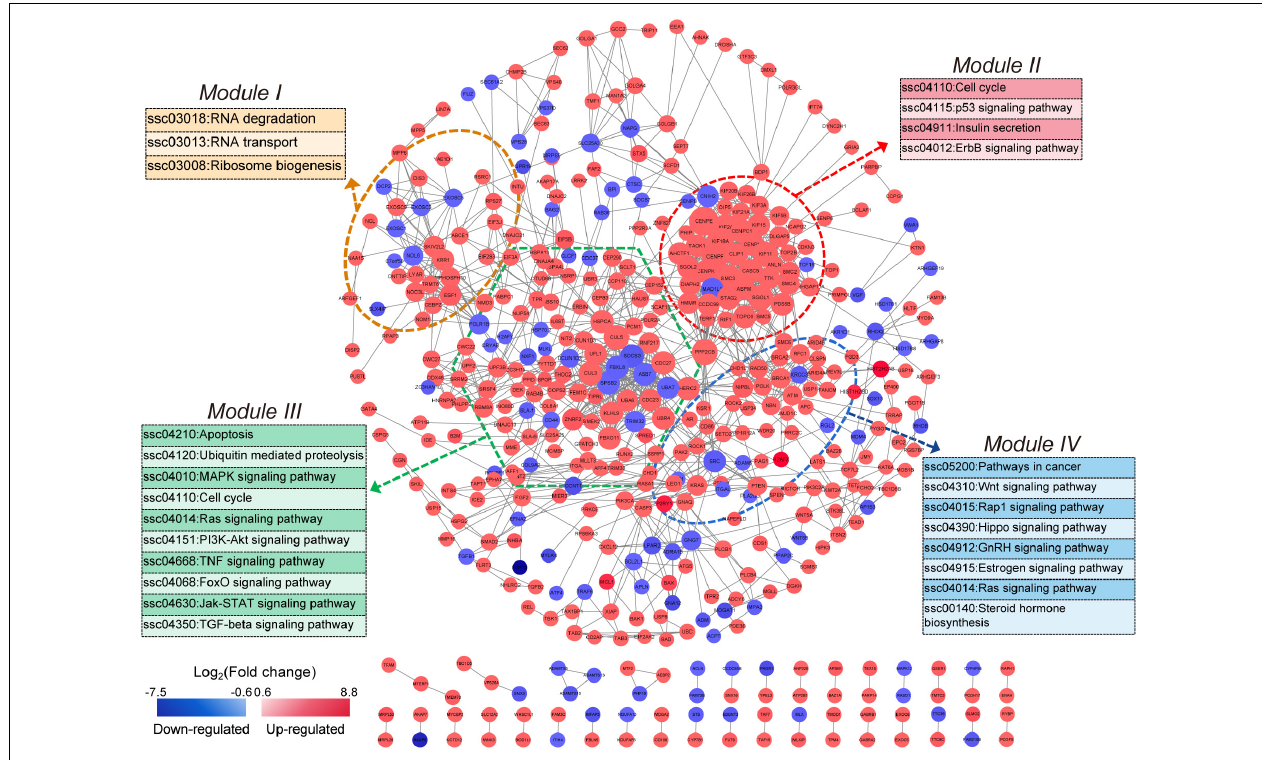
FIGURE 4 | Identification of the NORFA -mediated protein–protein interaction network. The NORFA -mediated protein–protein interaction (PPI) network was constructed based on the DEmRNAs obtained from RNA-seq results. A total of 462 protein-coding DEmRNAs (nodes) were identified in the PPI network. Color scale depicts the expression pattern of DEmRNAs and ranges from blue to red (red indicates up-regulated and blue indicates down-regulated). Degrees are shown as the size of the nodes. The dotted areas indicate four significant modules (module I in orange, module II in red, module III in green, and module IV in blue). The most enriched signaling pathways ( P < 0.05) represented by the four modules are